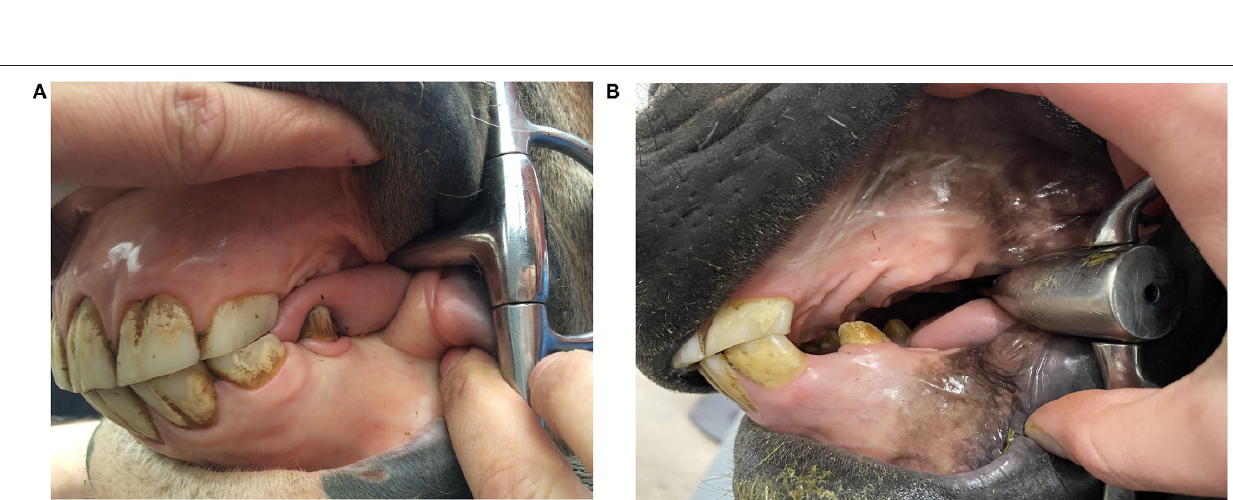
Frontiers in Veterinary Science |